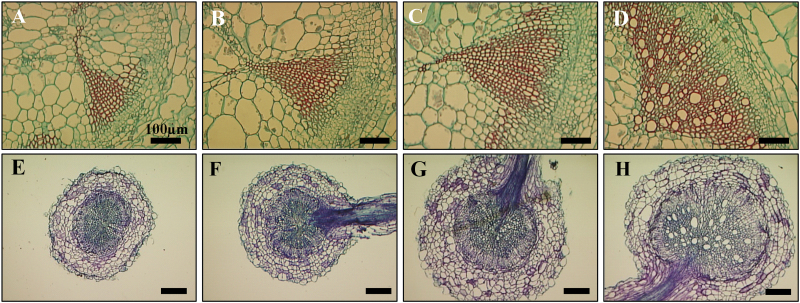
Ultrastructural changes in stems and roots in dgt, control, and transgenic plants expressing SlCyp1 in the phloem. Transverse sections of stems (A–D) and roots (E–H) in dgt mutants (A, E), SlCyp1-PX-2 (B, F), SlCyp1-PX-9 (C, G), and VFN8 control plants (D, H). Stems of dgt mutants exhibit small numbers of narrow and fibrous xylem vessels (A, E) compared to VFN8 control plants (D, H). Note the lateral-root sites of origin (F–H). Stem sections were excised ~3 cm below the cotyledons. Root sections were excised ~2 cm below the shoot–root junction. Scale bars = 100 µm.